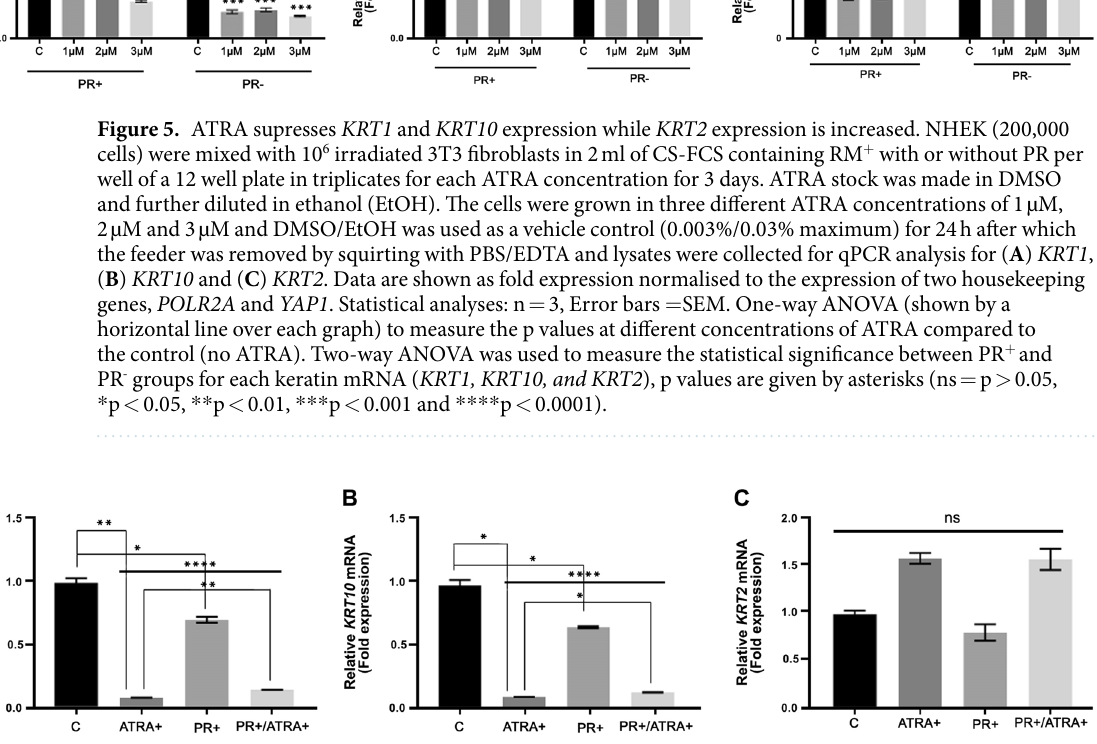
Figure 6. PR supresses mRNA expression for KRT1 and KRT10 in NHEK. NHEK (200,000 cells) were mixed with 10 6 irradiated 3T3 fibroblasts in 2 ml of CS-FCS containing and PR free RM + medium per well of a 12 well plate in triplicates for each growth condition. PR was dissolved in this medium at a concentration similar to that used in normal culture medium (0.01 mg/ml). NHEK were cultured in this medium for 3 days either with or without 1 µ M ATRA added in the last 24. The feeder was removed by squirting PBS/EDTA after which cell lysates were collected for qPCR gene expression analysis for ( A ) KRT1 , ( B ) KRT10 and ( C ) KRT2 . Control cells were treated with DMSO/EtOH (0.001%/0.01%). Data are shown as fold expression normalised to the expression of two housekeeping genes, POLR2A and YAP1 . Statistical analyses: n = 3, Error bars = SEM, Student’s t-test was performed to calculate p-values using Microsoft Exel. One-way ANOVA (shown by a horizontal line over each graph) was used to determine the statistical significance in gene expression between different growth conditions. The p values are shown by asterisks (ns = p > 0.05, * p < 0.05, ** p < 0.01 and **** p <